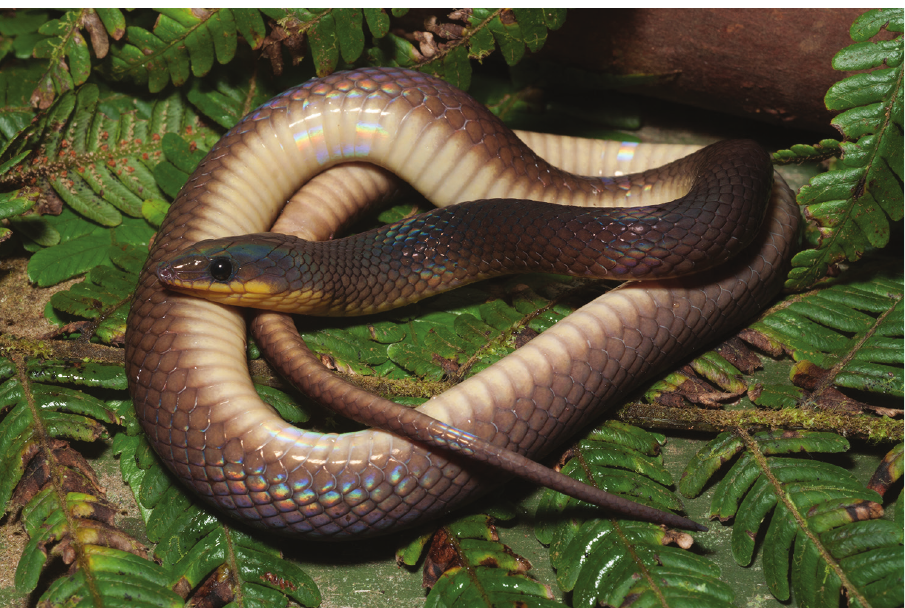
Figure 76. Oxyrhabdium modestum (KU 334388) from May-Impit, Mt. Hilong-hilong, Municipality of Remedios T. Romualdez, Agusan del Norte Province. Photo: